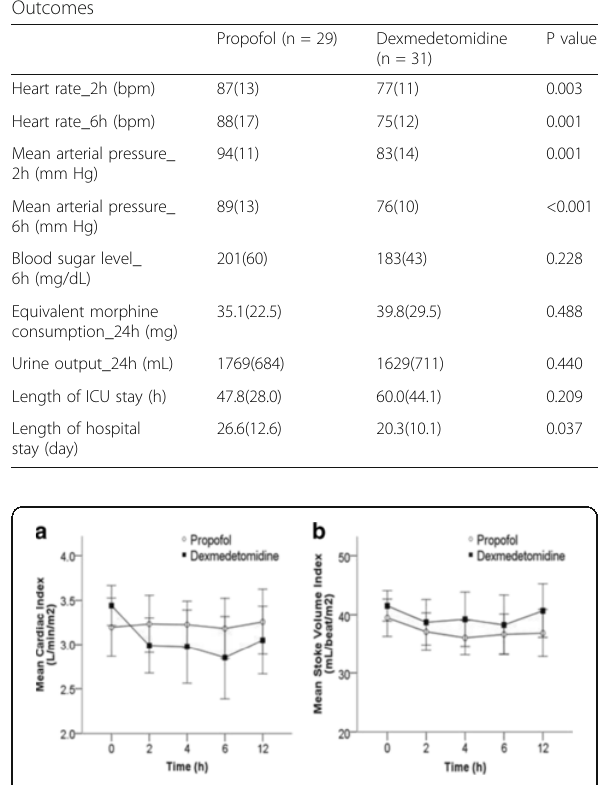
Fig. 66 (abstract A147). Cardiac index and Stroke Volume